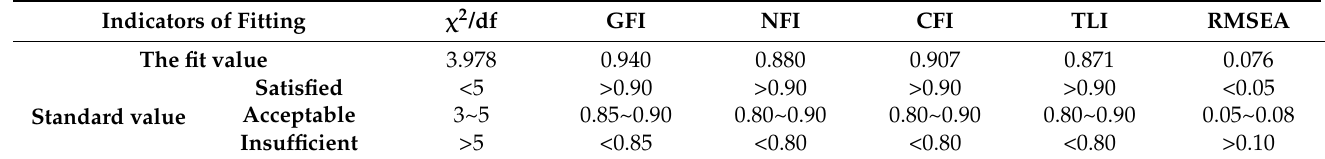
Table 10. The fitted results for